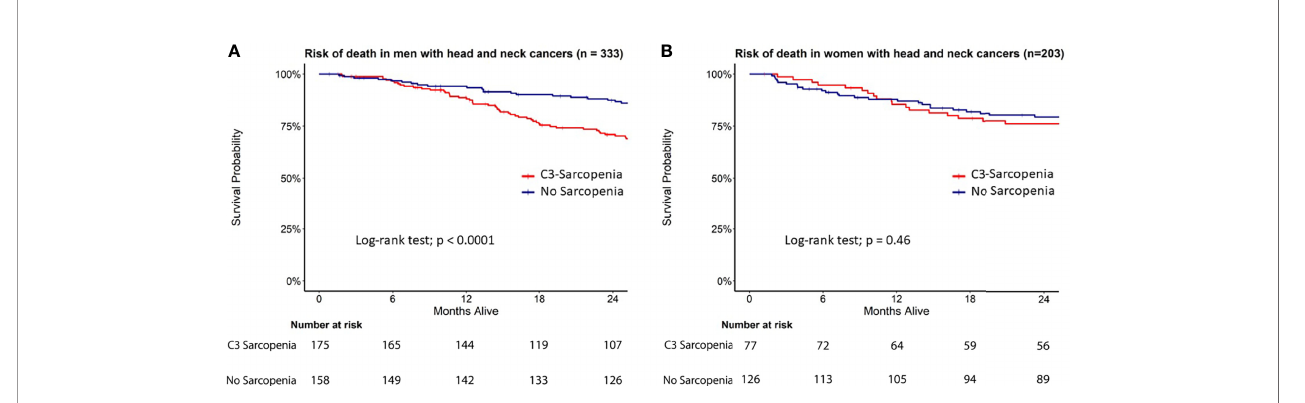
FIGURE 3 | Survival analysis in C3-de fi ned sarcopenic male and female HNC patients. Kaplan Meier curves for (A) men and (B) women strati fi ed by C3